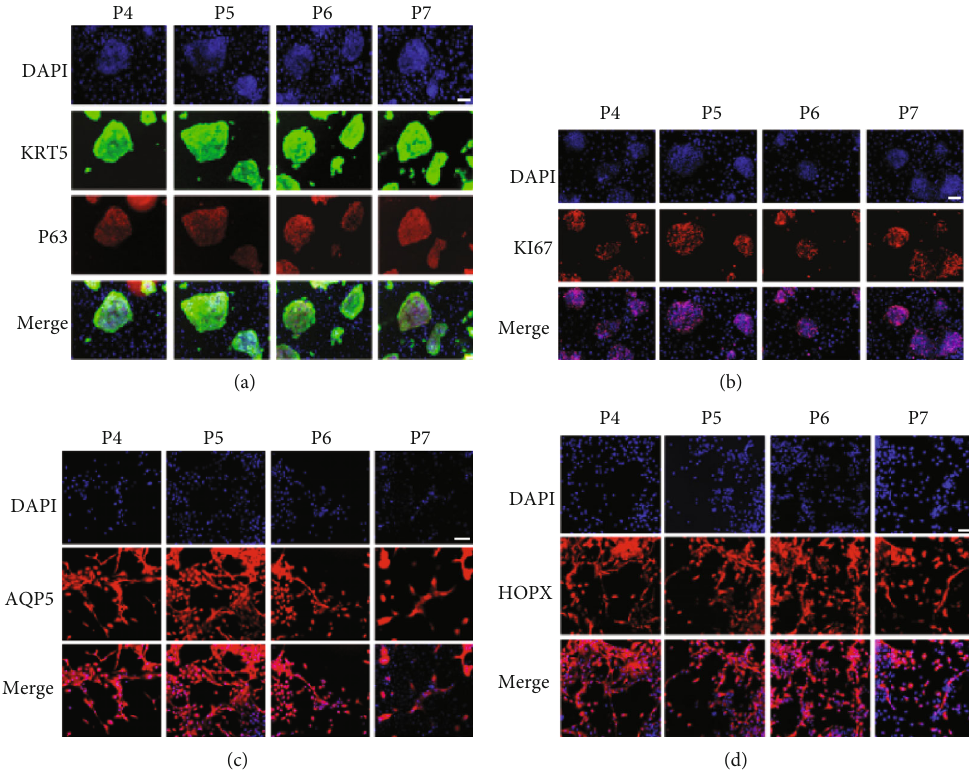
Figure 2: Expansion of hDASCs under the pharmaceutical-grade condition. (a) Clonogenic cells immunostained with hDASC markers KRT5 and P63 among P4 to P7. Scale bar, 100 μ m. (b) Clonogenic cells immunostained with proliferative markers KI67 among P4 to P7. Scale bar, 100 μ m. (c, d) Immunostaining of indicated AEC1 markers AQP5 and HOPX on monolayer-di ff erentiated DASCs. Scale bar, 100 μ